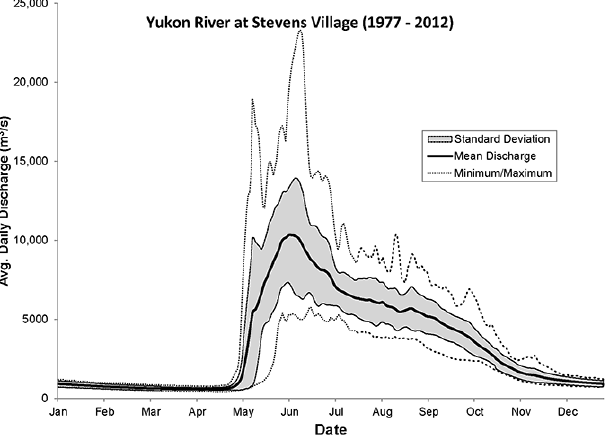
Fig. 2 . Average monthly discharge of the Yukon River at Stevens Village, Alaska, gauging station for 1977 to 2012 illustrates the typical spring breakup flood and the larger “June rise” that occurs soon after spring breakup. The driftwood mobilization threshold is also depicted. Figure based on data from U.S. Geological Survey gauging station for Yukon River at Stevens